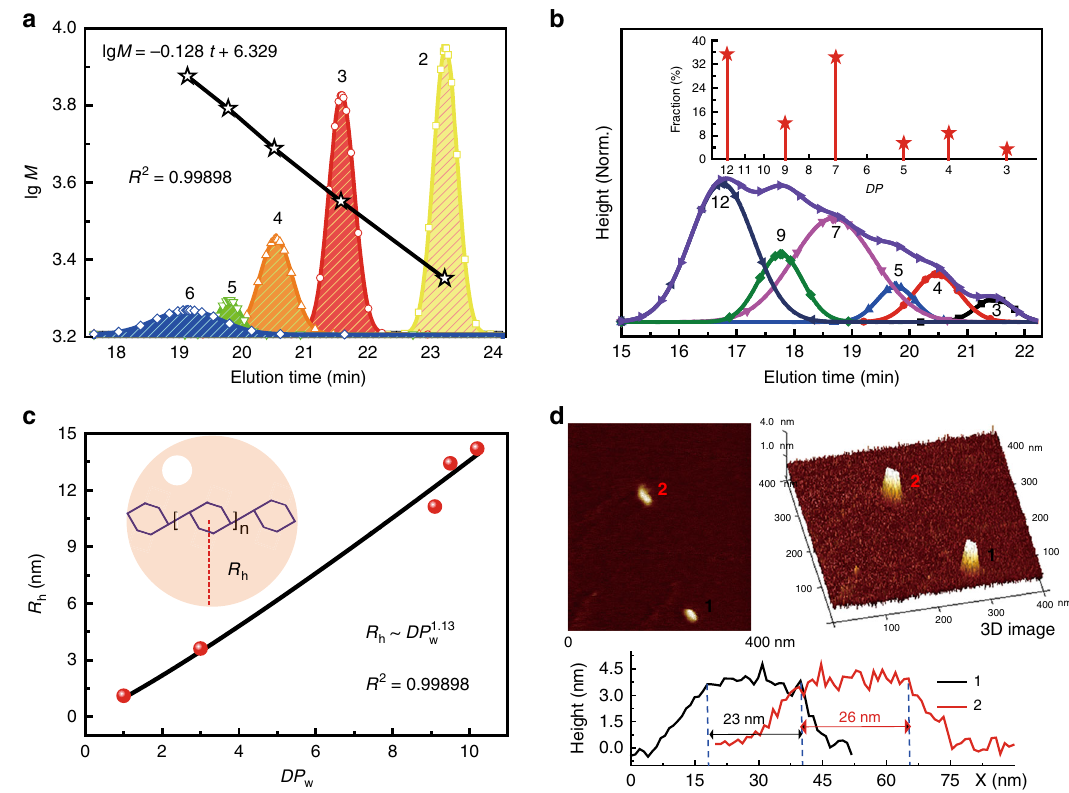
Fig. 4 Characterizations of the linear con fi guration of PDHG-F main chains. a The calibration of PDHG-F with lower molecular weight (the coef fi cient of determination R 2 is 0.99898). The yellow, red, orange, green, and blue peaks corresponds to dimer, trimer, tetramer, pentamer, and hexamer, respectively (in which the star dots exhibit their individual logarithmic molecular mass lg M and elution time t ). b The GPC analysis of PDHG-F. The broad elution peak (violet lines) is divided into a series of gauss peaks (in black, red, blue, magenta, olive, and navy lines) with well-de fi ned degree of polymerization, in terms of the extrapolation of PDHG-F calibration. The height of red star columns represents the proportion of each degree of polymerization. c The hydrodynamic radius ( R h ) of PDHG-F with different weight-average degrees of polymerization (DPs), marked in red dots. The black lines exhibit the DP dependence of hydrodynamic radius R h ( R 2 = 0.98473). The blue lines depict the linear PDHG-F backbones. Its hydrodynamic model in solutions is represented as the orange sphere whose radius (red line) is identical to R h . d The atomic force microscope images of the PDHG-F chains (two chains labeling 1 and 2) including 2D and 3D image. In the height analysis, the size between two blue dashed lines (above 3.2 nm) exhibits the chain length of visualized PDHG-F (black for 1 and red for